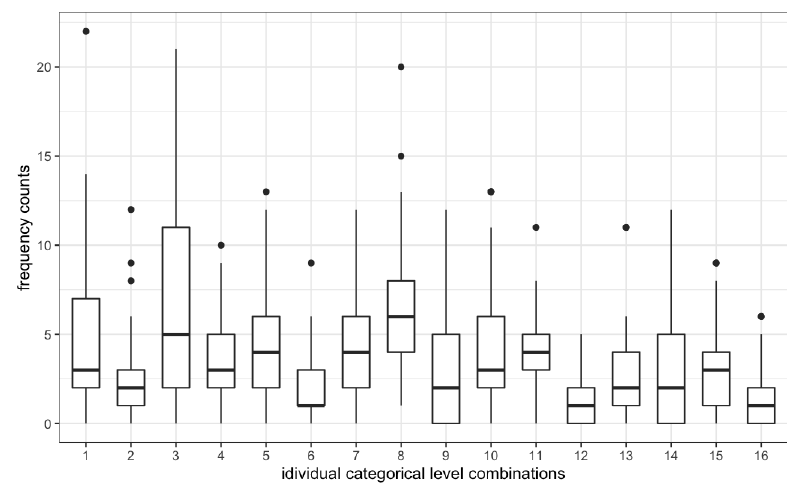
Figure 2. Quarterly frequency counts on specified